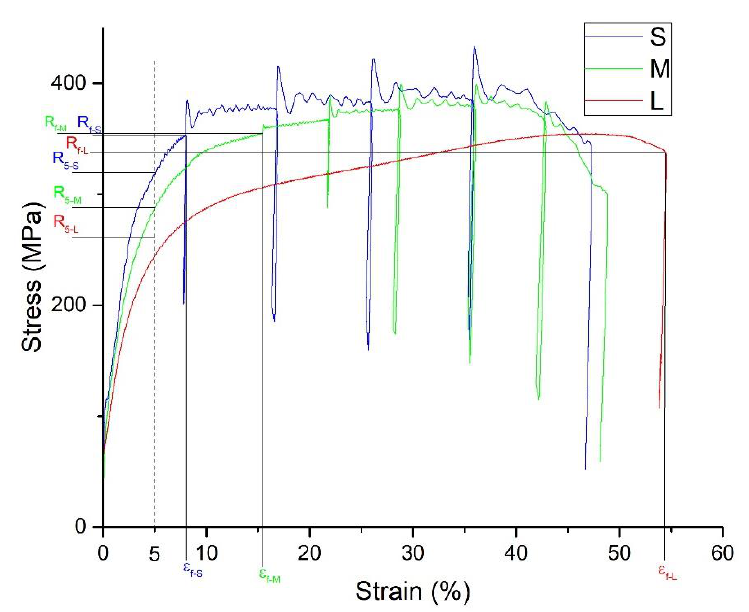
Figure 7. Stress–strain diagrams from samples of casting No. 5. Table 4. SDAS, mechanical properties, and cooling rates for samples from the castings. Casting